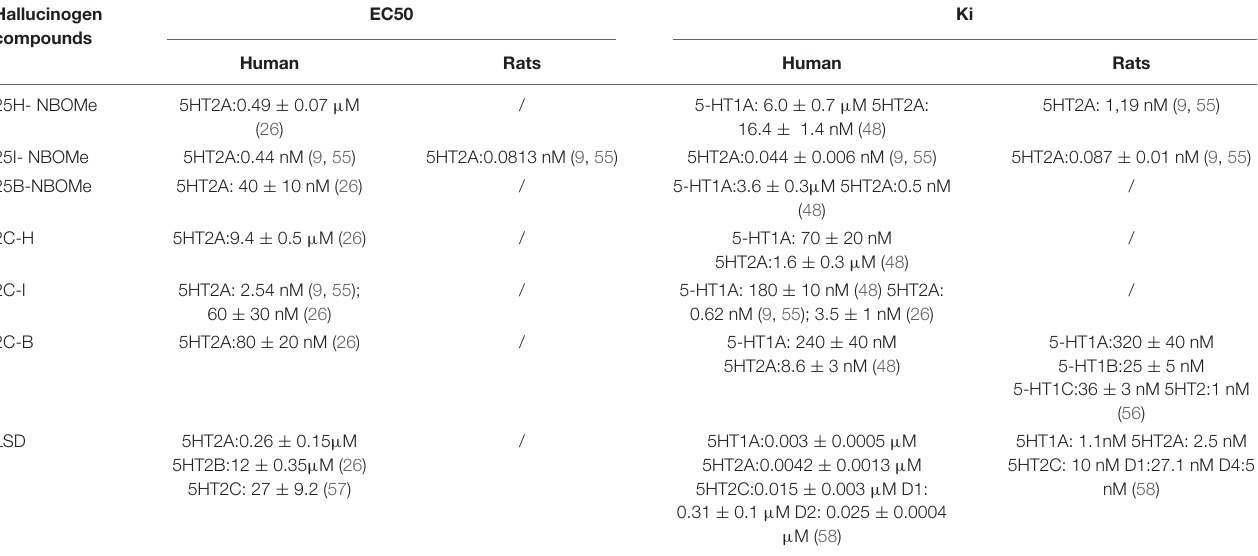
TABLE 3 | Different EC 50 and Ki values of LSD, 2C compounds, and -NBOMe series on human and rat receptors. Hallucinogen compounds